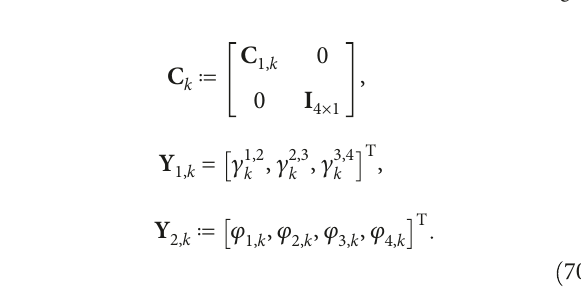
Figure 8: Estimation errors in general formation. (a) Position. (b)